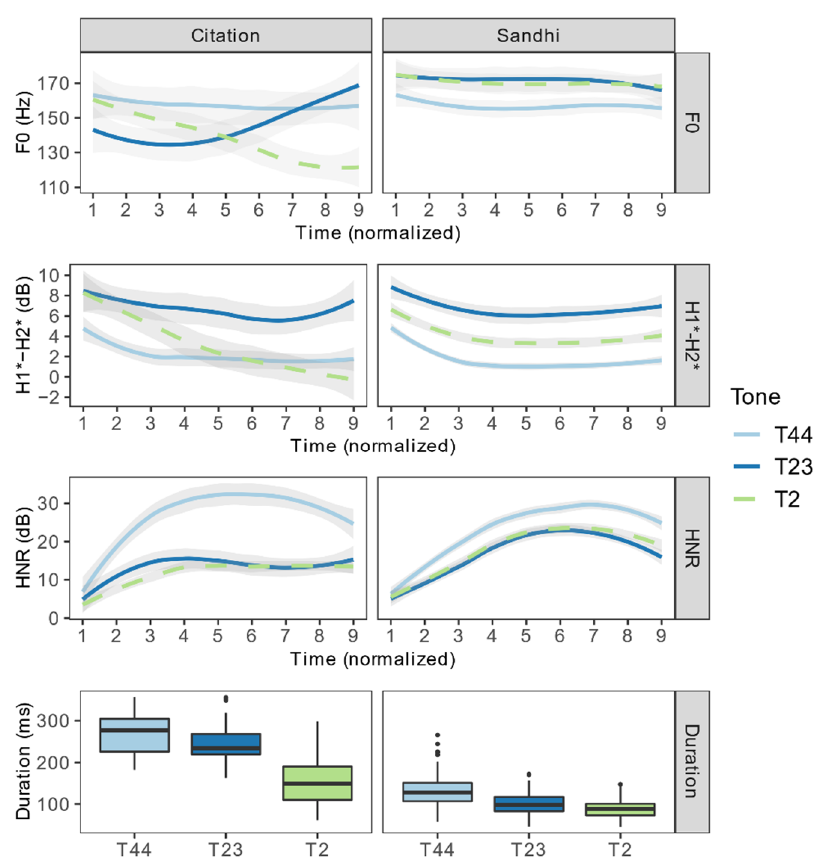
Figure 11. Acoustic parameter values of T44, T23, and T2 in citation and sandhi forms.